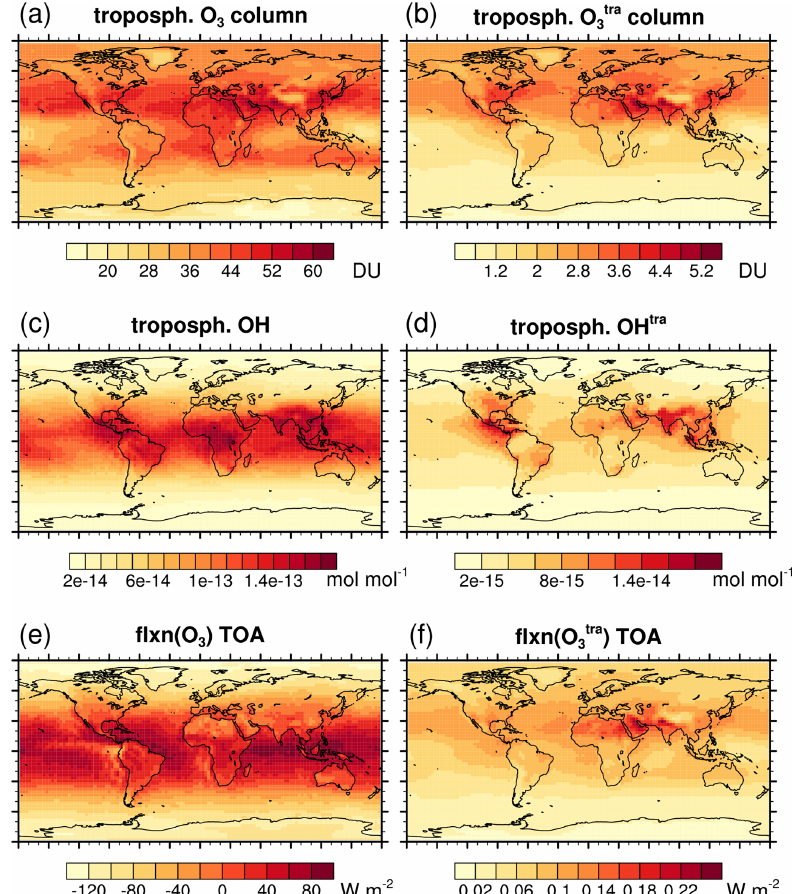
Figure A1. Ozone (O 3 ), hydroxyl radical (OH) and ozone net radiative fluxes (flxn(O 3 )) as well as the contribution to ozone (O tra hydroxyl radical (OH tra ) and to ozone net radiative fluxes (flxn(O tra scaling factors are given in Table 3. The tropospheric columns of O 3 and O tra